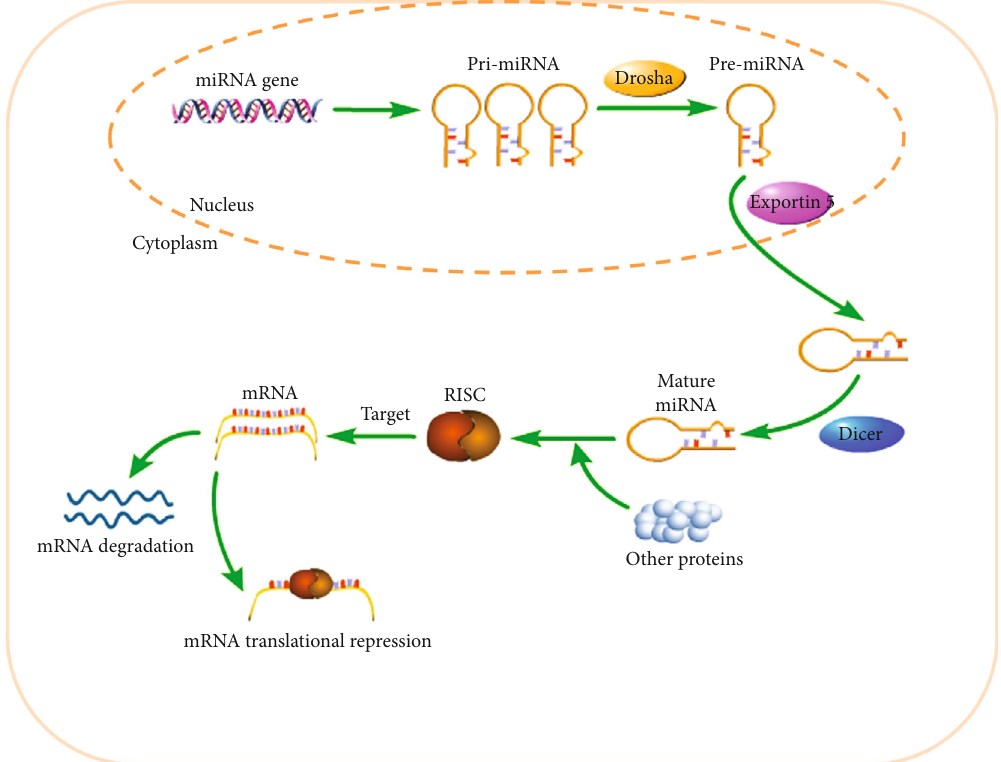
Figure 1: The forming process of